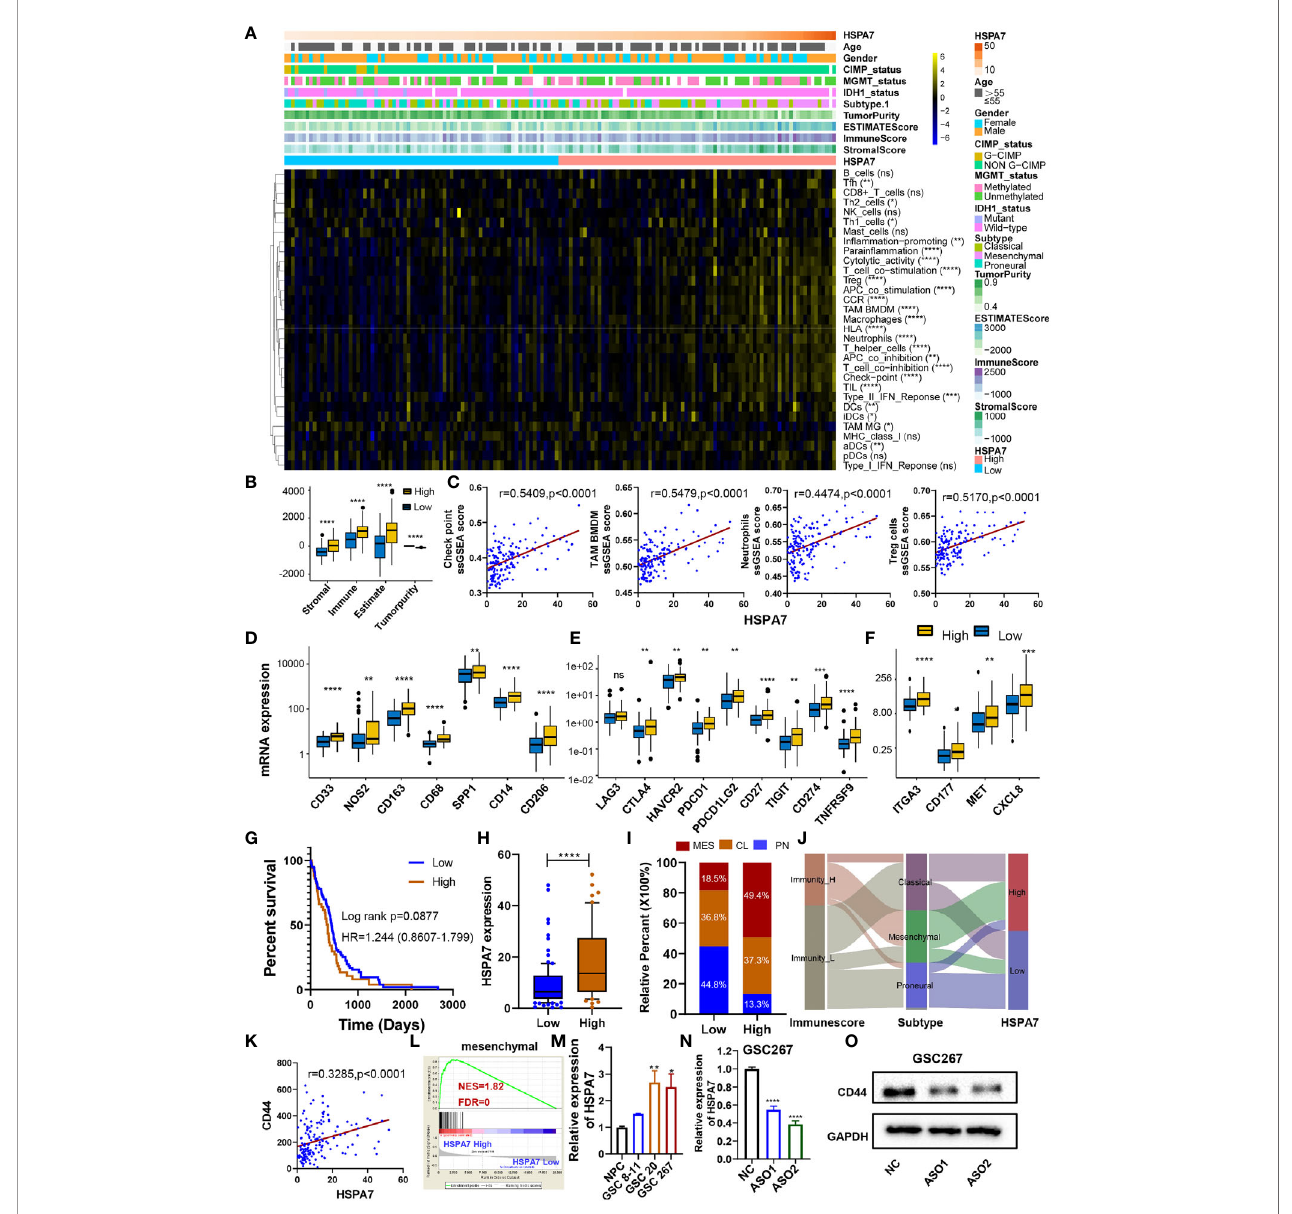
FIGURE 3 | HSPA7 is correlated with immunophenotypes and TME landscapes. (A) The enrichment scores of immune cell types and immune-related function- related gene sets were calculated via the ssGSEA algorithm. A heatmap was used to visualize these immune characteristics between the HSAP7 high and low expression groups; yellow represents a high enrichment level, black represents a median enrichment level, and blue represents a low enrichment level. (B) High expression of HSPA7 presented signi fi cantly increased stromal, immune, and ESTIMATE scores and decreased tumorigenicity. (C) HSPA7 positively correlated with immunosuppression regulators (checkpoints, macrophages, neutrophils, and Tregs). High expression of HSPA7 presented signi fi cantly increased markers of (D) suppressor function of myeloid lineages, (E) immune inhibitory checkpoints and (F) major neutrophil-recruiting chemokines and their receptors. The asterisks indicate a signi fi cant statistical p-value calculated using the non-parametric Wilcoxon test (*P < 0.05; **P < 0.01; ***P < 0.001, ****P < 0.0001). (G) Compared to the immune- L group (102 patients), patients in the immune-H group (51 patients) experienced poorer prognoses. (H) HSPA7 expression was higher in the immune-H group than in the immune-L group. (I) The proportion of GBM molecular subtypes in the low and high HSPA7 groups. MES subtype, red; CL subtype, orange; PN subtype, blue. (J) Alluvial diagram showing the changes in immune phenotypes, GBM molecular subtypes, and HSPA7 expression. (K) HSPA7 positively correlated with CD44, a marker of the MES subtype. (L) GSEA of mesenchymal signatures showed that GBM samples with high HSPA7 expression were enriched in the MES subtype compared to GBM samples with low HSPA7 expression. NES, normalized enrichment score; FDR, false discovery rate. (M) qPCR assays showed that HSPA7 expression was higher in MES subtype GSCs (GSCs 20 and 267) than in PN subtype GSCs (GSCs 8 – 11) and neural stem cells (NPCs). (N) qPCR assays veri fi ed the knockdown ef fi ciency of HSPA7. (O) Western blot assays showed that HSPA7 promoted the expression of CD44. The statistical signi fi cance is shown as: ns, P > 0.05; *P < 0.05; **P < 0.01; ***P < 0.001; ****P <